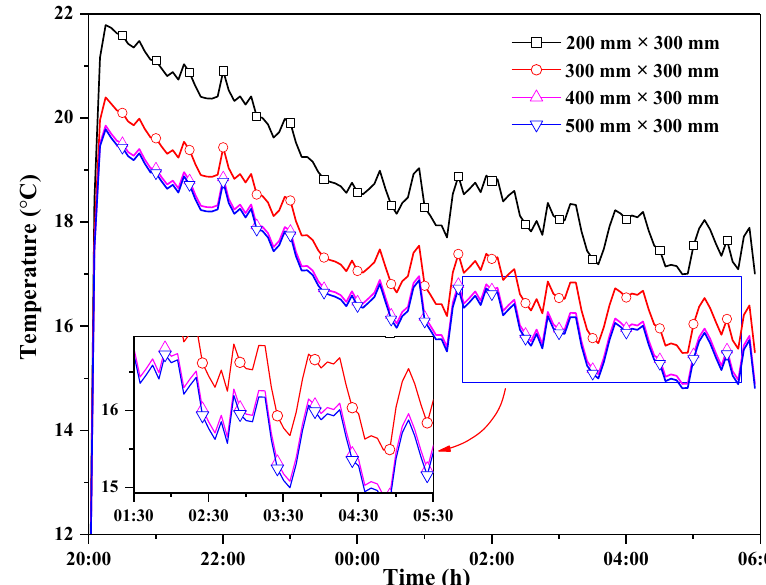
Figure 19. Time-dependent variation of the component surface temperature with different lengths of the radiative plate.